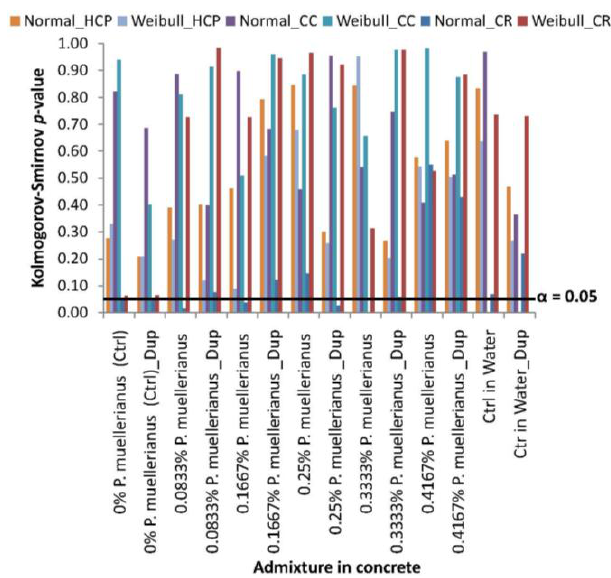
Figure 2. Kolmogorov-Smirnov goodness-of-fit test-results of the scatter of corrosion test data from the concrete samples like the Normal and the Weibull distributions.